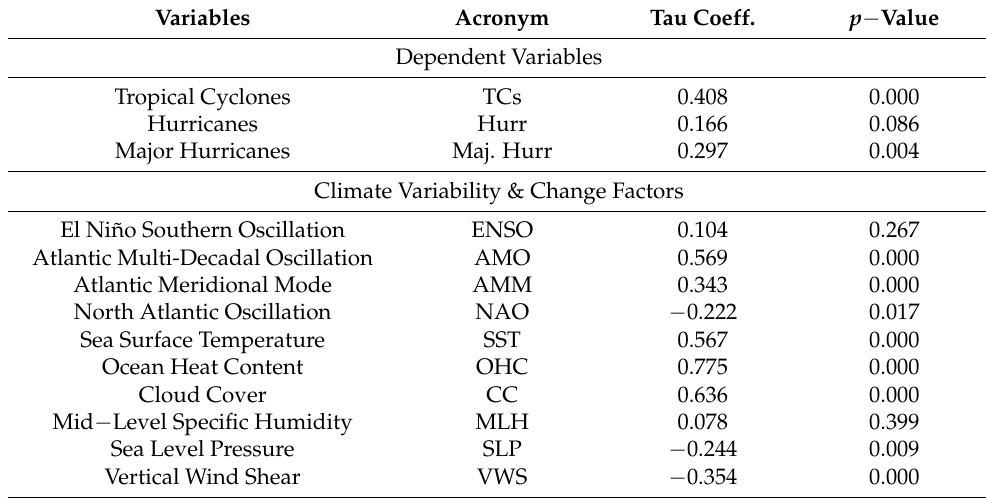
Table 1. Mann–Kendall trend test results for all the variables. Higher Tau coefficients (>0.2) are associated with statistically significant probability values ( p -values) of 0.05 or less. Variables Tau